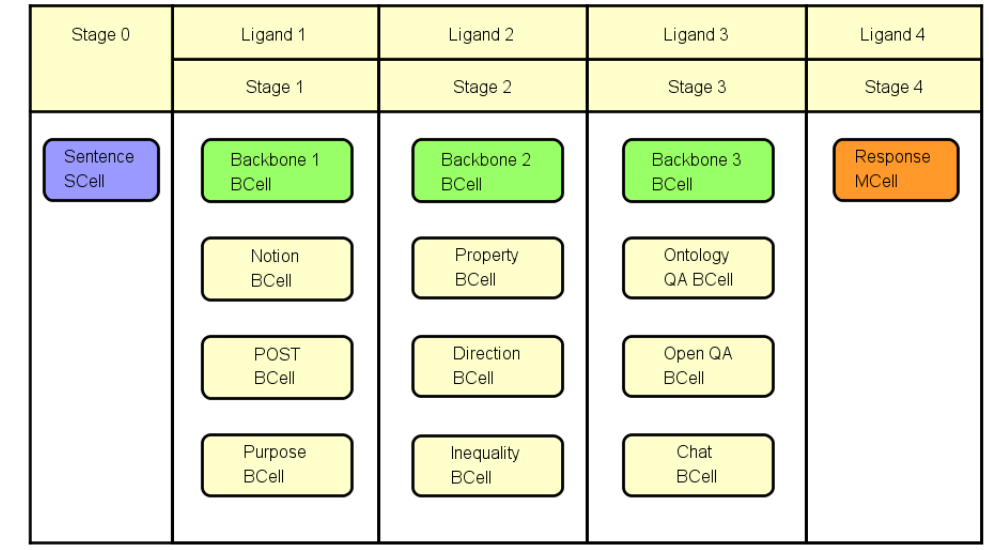
Figure 15. This is an artificial intelligence application in dialogue system.